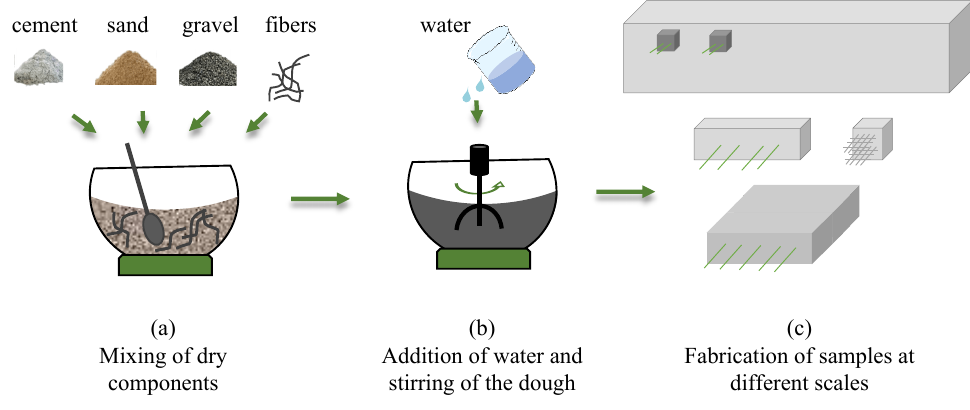
Figure 2. Preparation procedure for smart